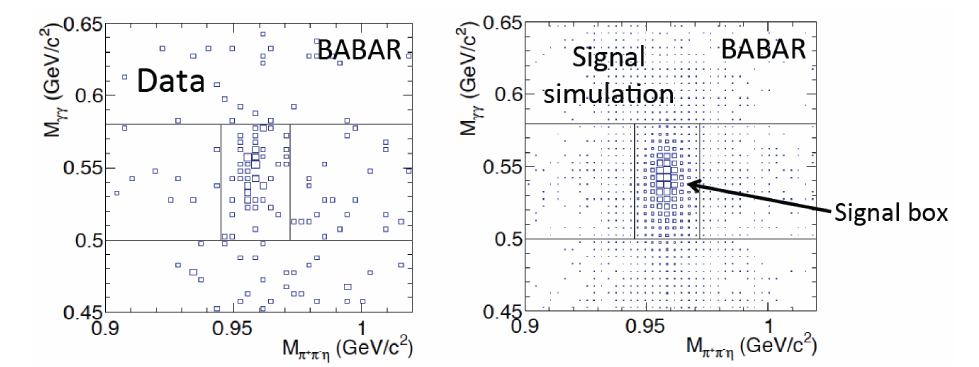
Figure 4. Scatter plots for (left) data and (right) signal event simulation of the candidate η mass versus the candidate η (cid:48) mass. The signal box is indicated in the figure.